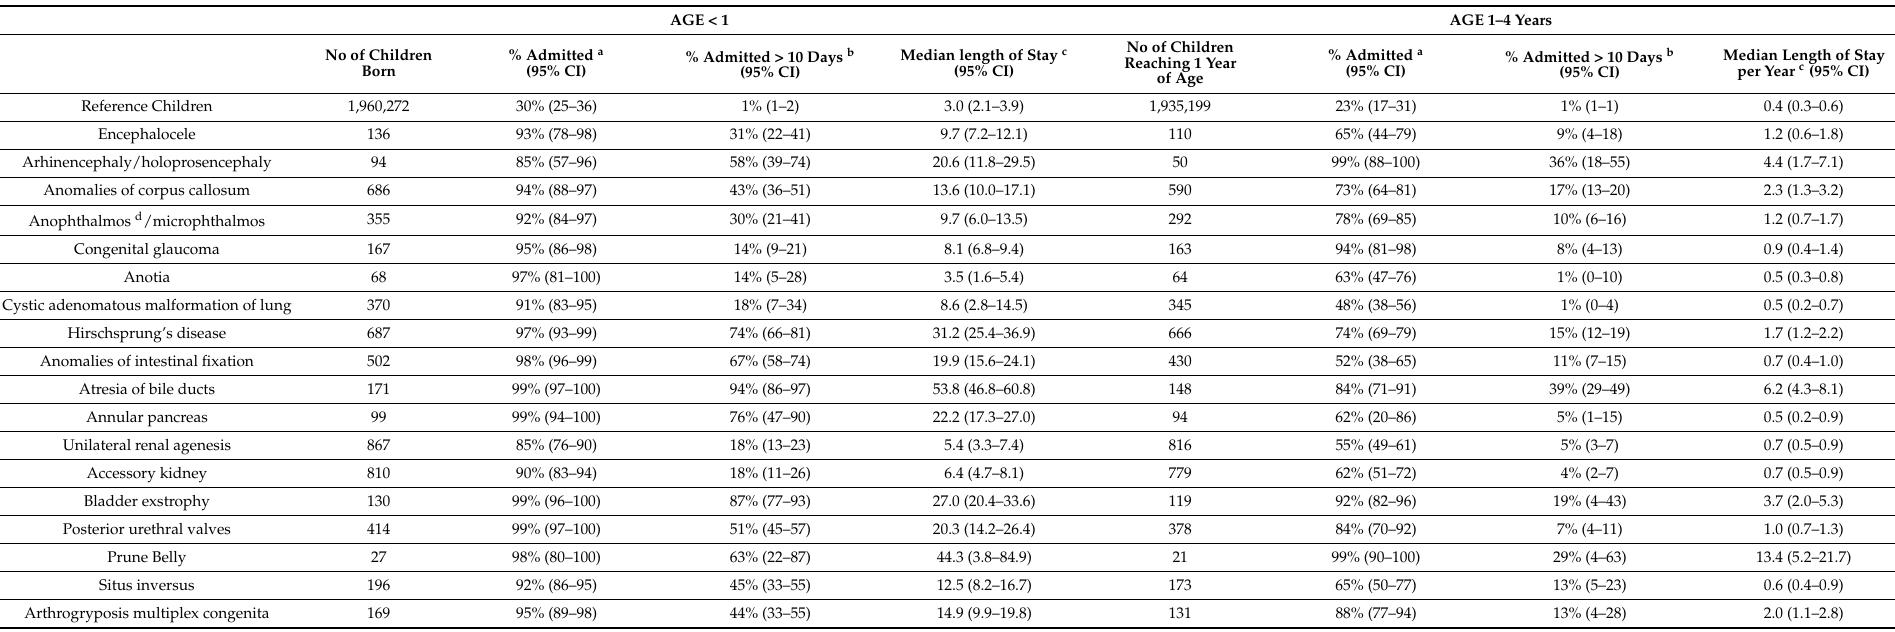
Table 1. Proportion of children admitted to hospital, proportion of term-born children with hospital stays of 10 days or more and median length of stay for children with 18 rare congenital anomalies and for reference children by age